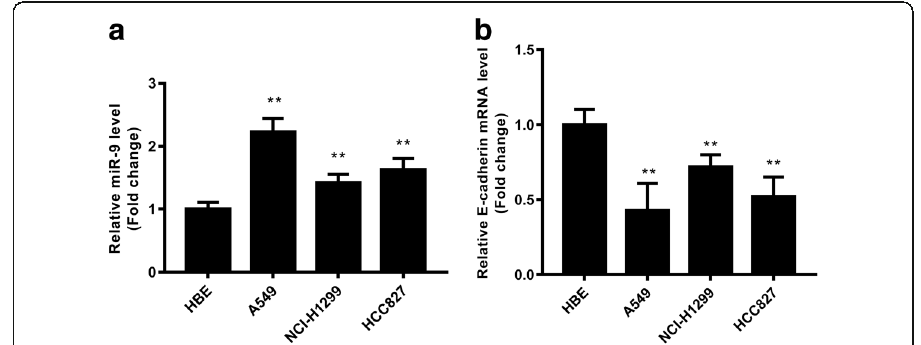
Fig. 2 Expression of miR-9 and E-cadherin in NSCLC cell lines. Relative expression of miR-9 ( a ) and E-cadherin mRNA ( b ) were assessed with qRT-PCR. * p < 0.01 vs. HBE